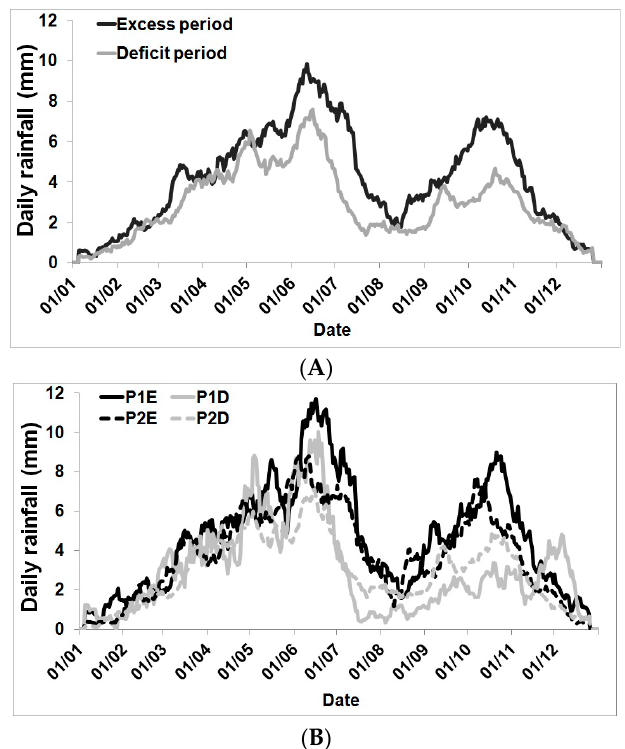
Figure 4. Average seasonal cycle composite periods: ( A ) Excess and deficit. ( B ) Excess (P1E: before 1968 and P2E: after 1968) and deficit (P1D: before 1968 and P2D: after 1968) at the Agboville station.